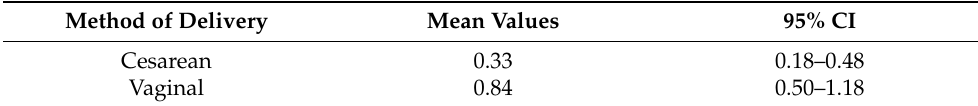
Table 3. The PUUS values of patients regarding the method of delivery ( p = .002).